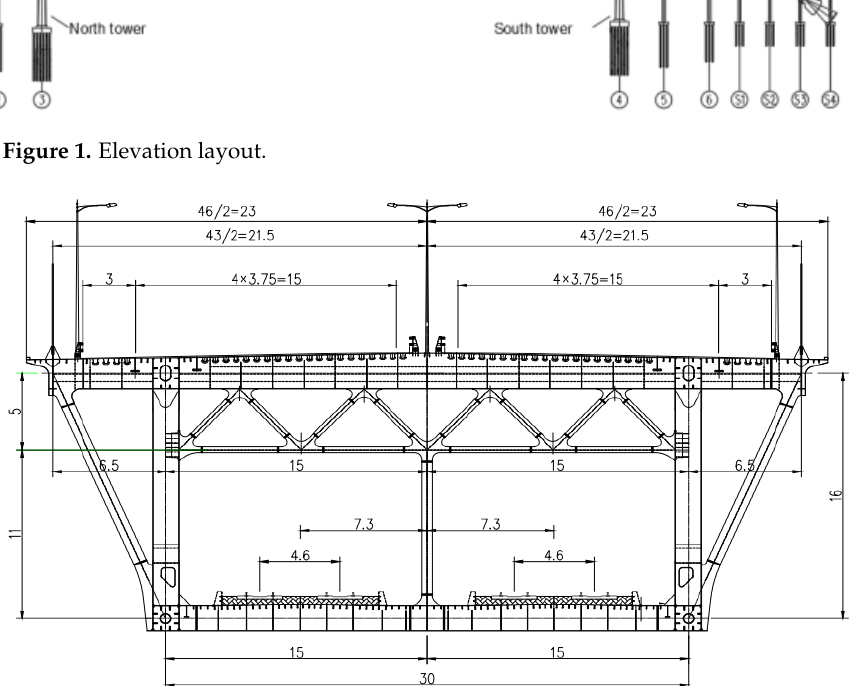
Figure 2. Cross section of stiffener beam.